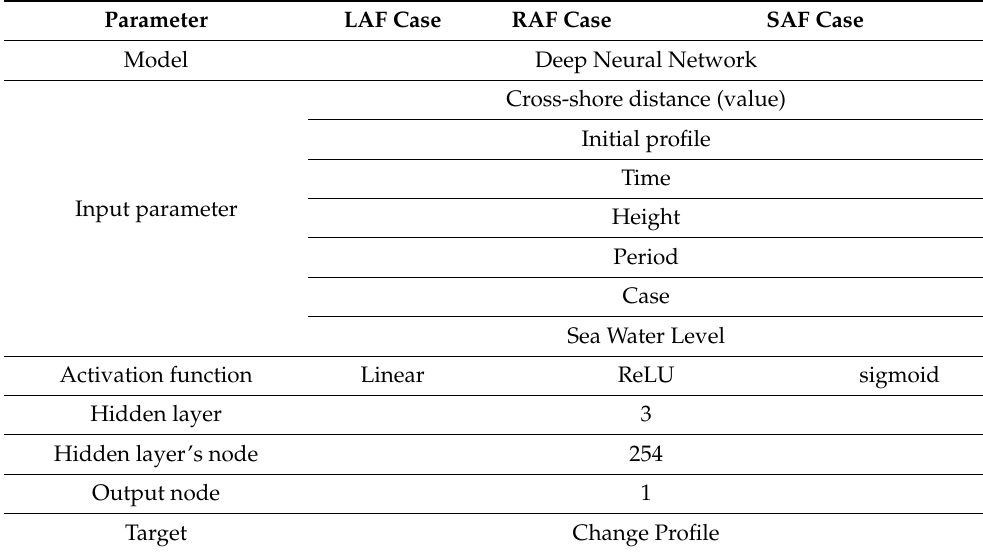
Table 2. Architecture of the present study.